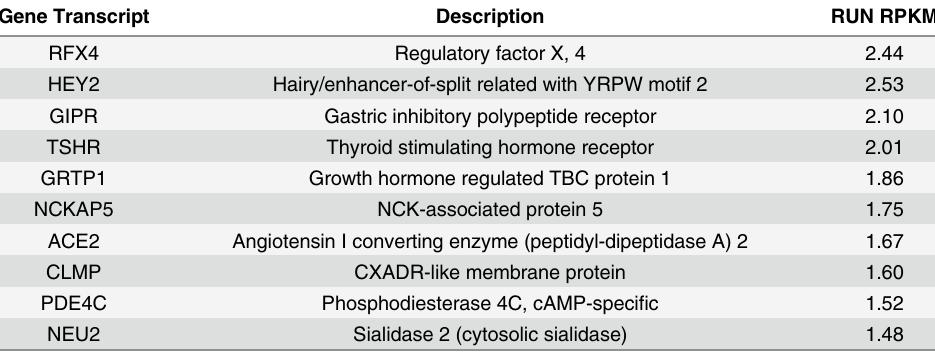
Table 4. Top 10 genes expressed in RUN but not LOCK, sorted by average RPKM.